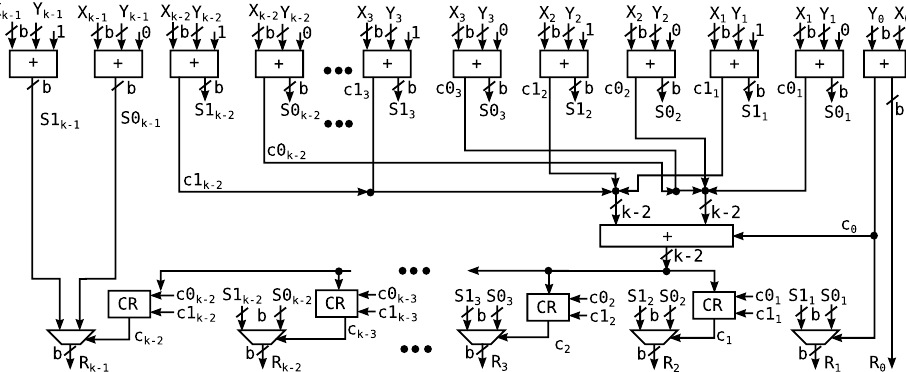
Figure 7: The optimized wide adder architecture Add-Add-Multiplex (AAM) from Nguyen et al. [NPP11]. In our implementation b =